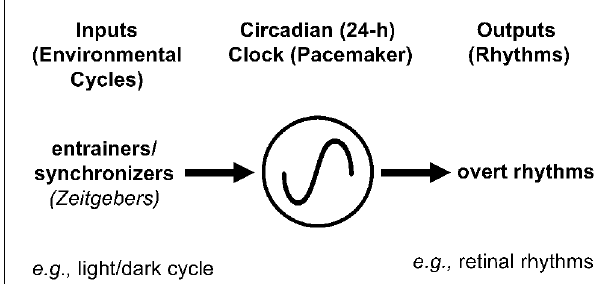
FIGURE 7 | Simplified circadian clock pathway in the retina. A simplified circadian clock pathway has three components. First, there is a molecular mechanism, which is referred to as a clock, clockwork, or a pacemaker, that has a period of approximately 24 h and is able to maintain its daily rhythmicity in the absence of environmental cues (e.g., in constant darkness and temperature). Second, although circadian clocks can maintain rhythmicity in a constant environment, they are entrained or synchronized to the local environment by zeitgebers (German for time-giver). For example, the daily light/dark cycle acts as an input to clocks because the onset of morning light resets the “hands” of clocks so that they are set to local time, even though environments do not alter the period of clocks. Third, circadian clocks produce daily rhythms at the molecular, cellular, and systems levels. For example, the circadian clock in the retina produces a variety of daily rhythms within the retina, including increasing the hormone melatonin at night, decreasing the neurotransmitter dopamine in the day, and enabling cone photoreceptors to respond to very dim light stimuli at night (but not in the day). Because circadian clocks are affected by environmental stimuli, circadian experiments, which aim to determine whether time of day or night affects a function (e.g., level of extracellular dopamine), are conducted in the absence of environmental cues (e.g., under conditions of constant darkness and temperature). In a circadian experiment, the terms “subjective day” and “subjective night (SN)” refer to the day and night of the imposed light/dark cycle, respectively, when animals or isolated intact retinas were maintained in constant